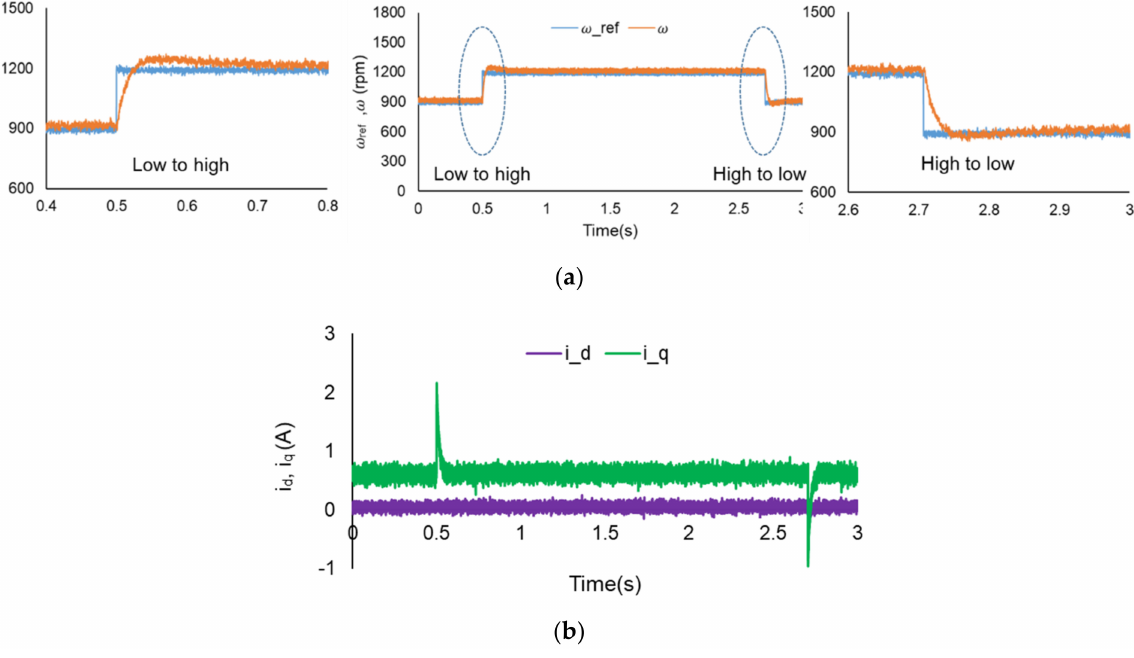
Figure 11. ( a ) Motor speed response; ( b ) current response for the sampling frequency of 50